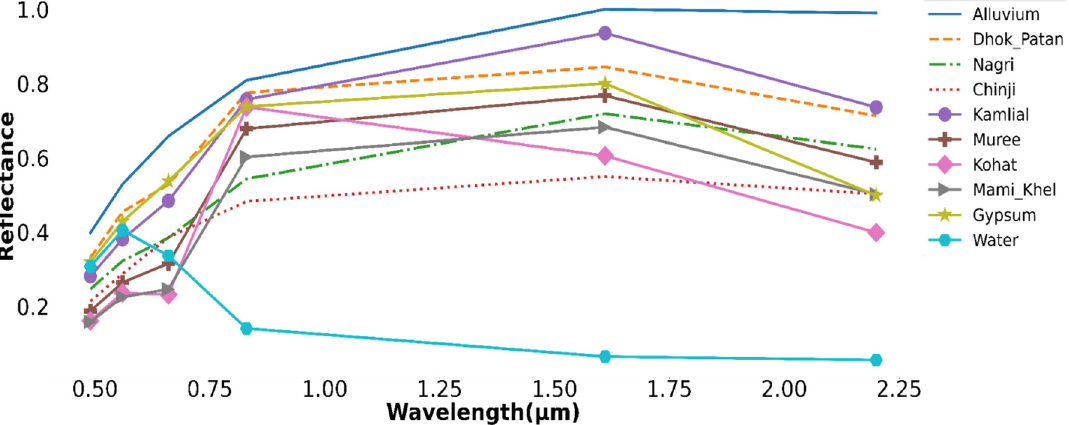
Figure 4. Average surface reflectance based on training samples selected from Sentinel-2 data for ten lithological units.